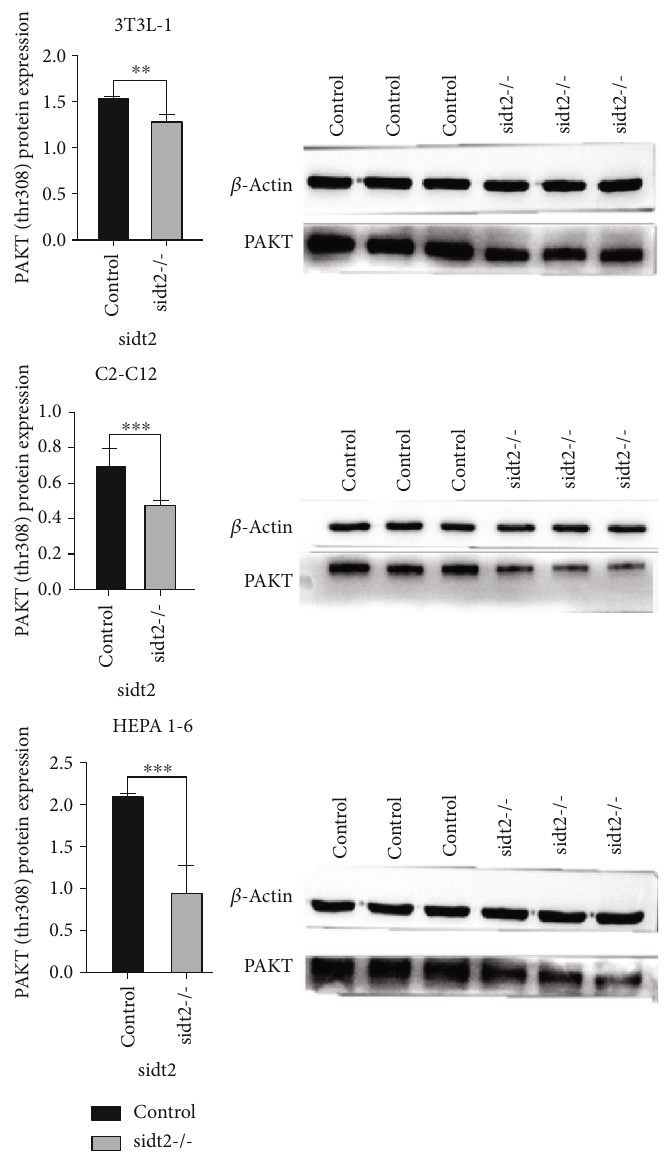
Figure 5: WB results of three cell lines ( ∗ : P < 0 : 05 , ∗∗ : P < 0 : 03 , ∗∗∗ : P < 0 : 01 ). The statistical chart shows that the expression of PAKT (thr308) in the sidt2 knockout group is lower than that in the control group, and the di ff erence is signi fi